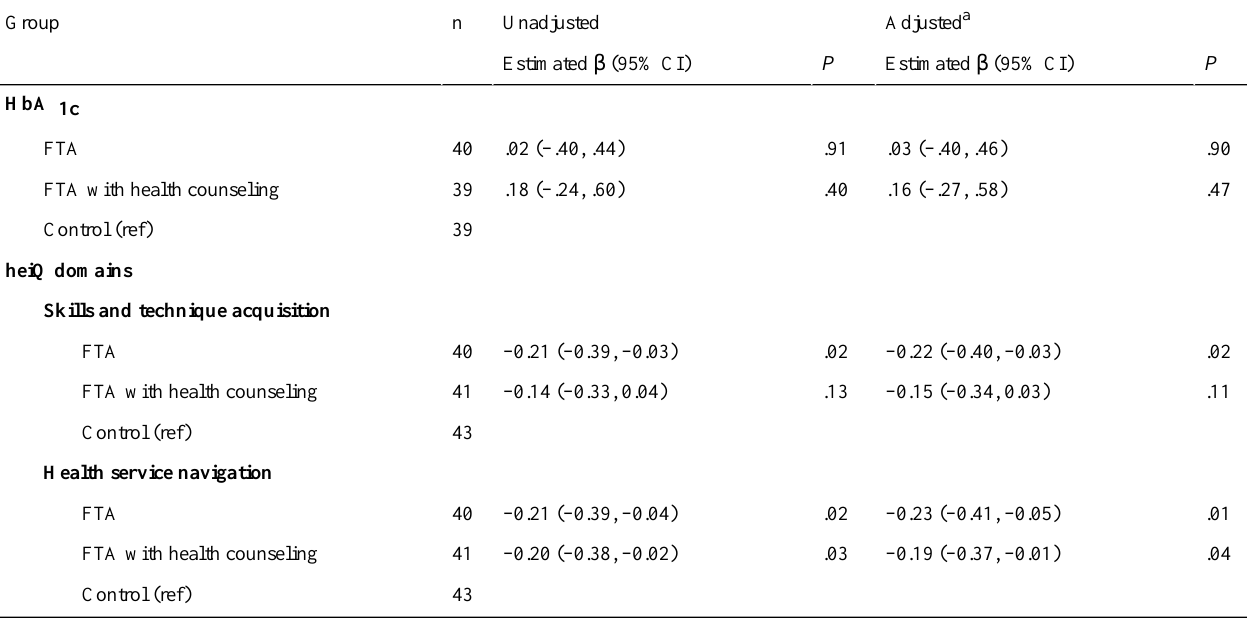
Table 6. Linear regression analysis with crude and adjusted values for HbA 1c and heiQ domains from baseline to 4-month follow-up.